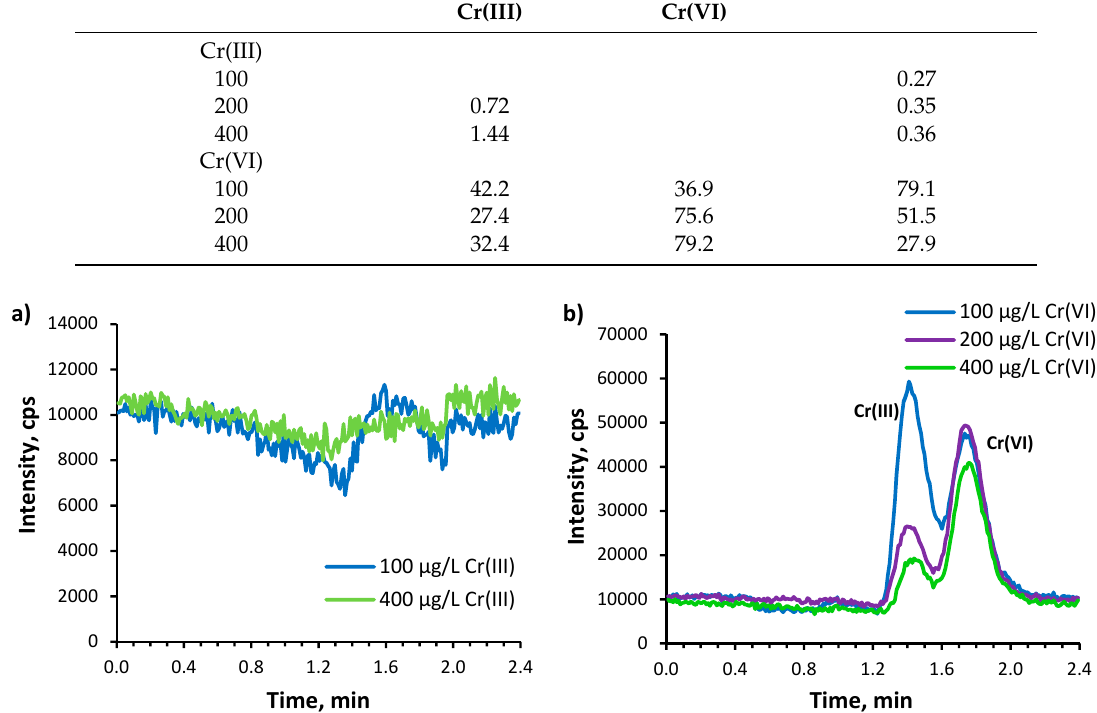
acid by HPLC-ICP MS method. Table 6. Concentration and recovery of Cr(III) and Cr(VI) spike determined in standards with humic